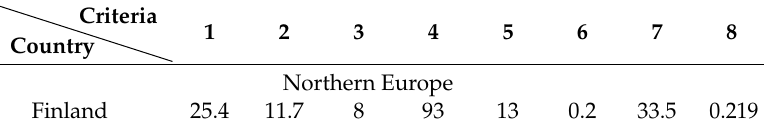
Table 12. Values of tax competitiveness criteria for